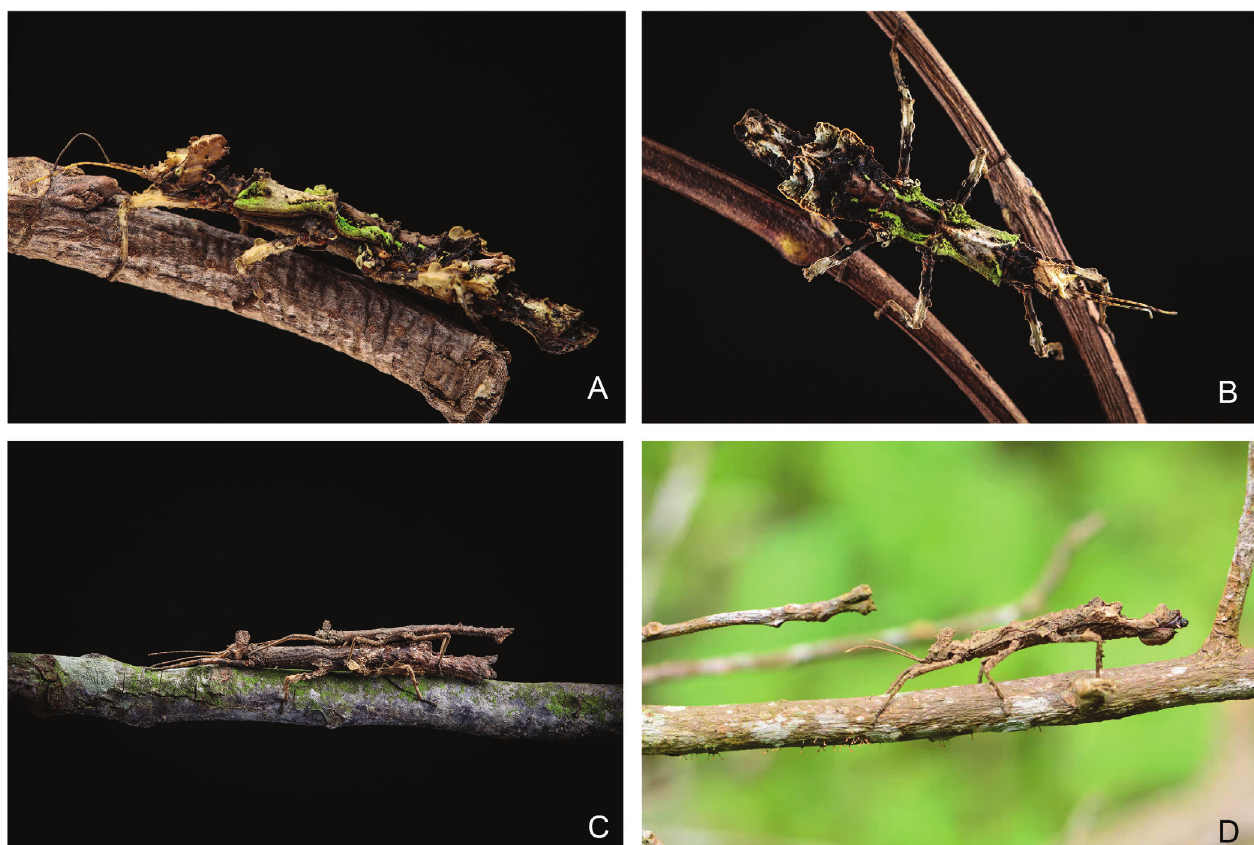
Fig. 3. Living photos. A, B. Pylaemenes gulinqingensis sp. nov. (Gulinqing, Yunnan, China); C. Hainanphasma cristata Ho, 2013 (Mt.